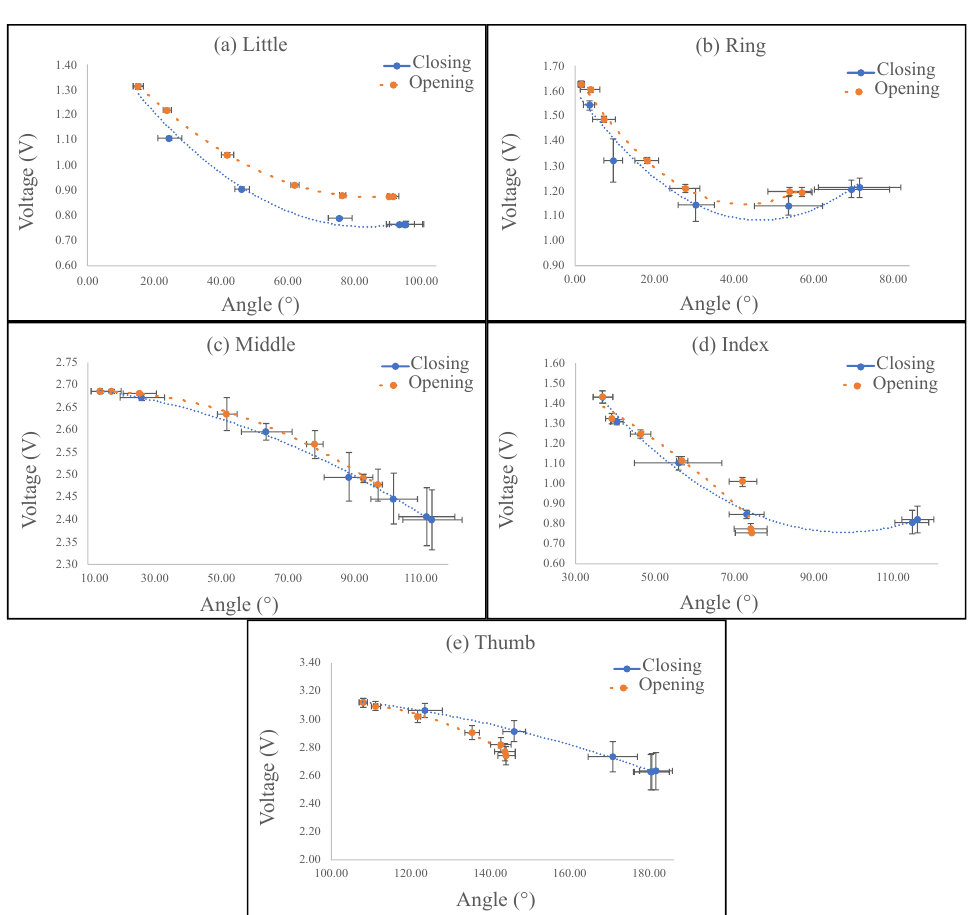
Figure 10. Angle sensor characterization per finger: the dotted blue line represents the closing and the dashed orange line the opening. ( a ) Little. ( b ) Ring. ( c ) Middle. ( d ) Index. ( e )